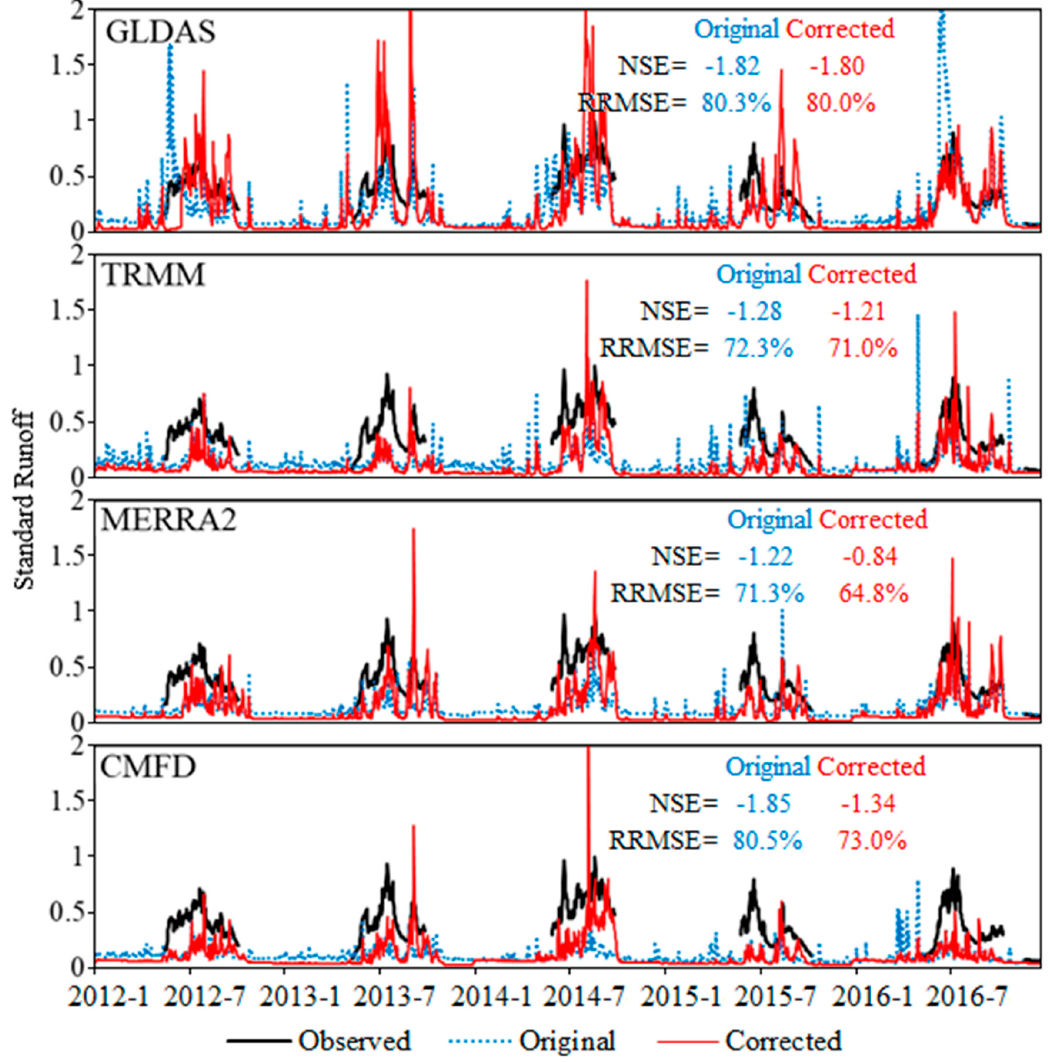
Figure 10. Comparison of simulated daily runoff (standard) forced by original and corrected precipitation.